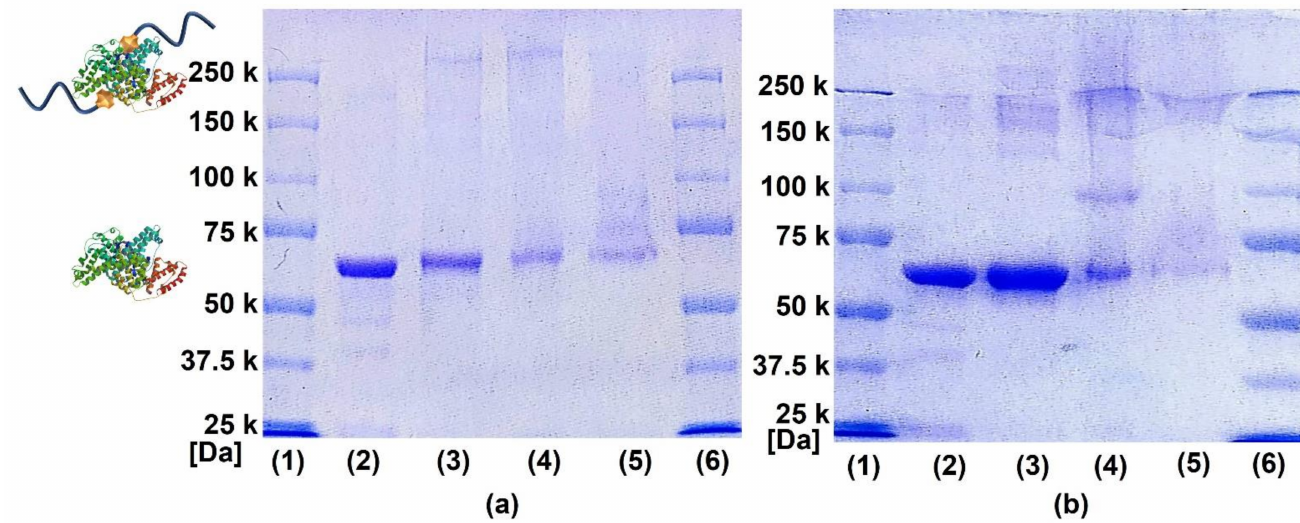
Figure 3. SDS-PAGE analysis for BSA-PNIPAAm conjugates: ( a ) Monomer ratio to CTA of BSA- PNIPAAm conjugates (lanes: (1) protein standard (2) BSA (3) B/C5/PN400 (4) B/C5/PN800 (5) B/C5/PN1600 (6) protein standard). ( b ) CTA ratio to BSA of BSA-PNIPAAm conjugates (lanes: (1) protein standard (2) BSA (3) B/C2/PN800 (4) B/C5/PN800 (5) B/C10/PN800 (6) pro- tein